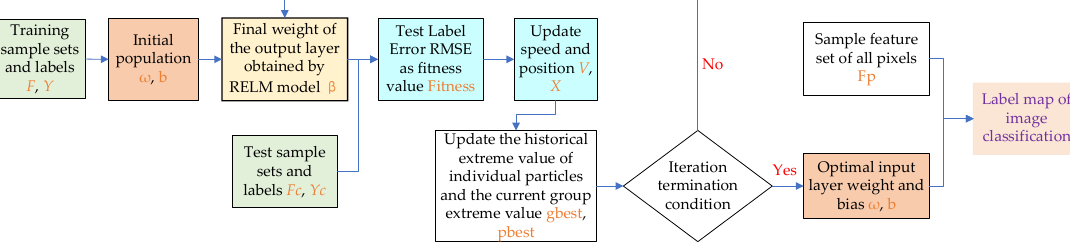
Figure 5. Intelligent optimization process of modified extreme learning machine (MELM) model.